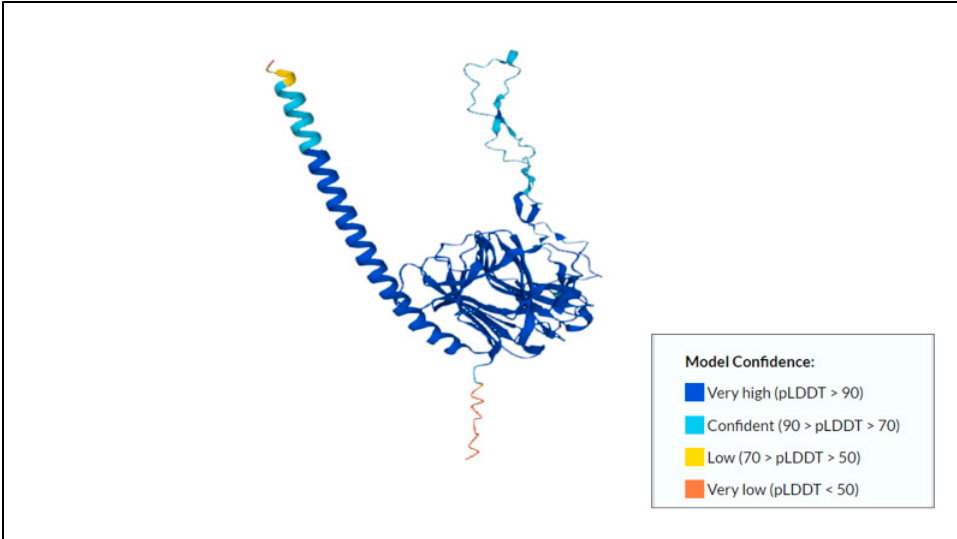
Figure 5. Predicted protein structure of calreticulin [41,75,78] (https://www.uniprot.org/uni- protkb/C4M296/entry, accessed on 25 October 2022). C4M296/entry, accessed on 25 October